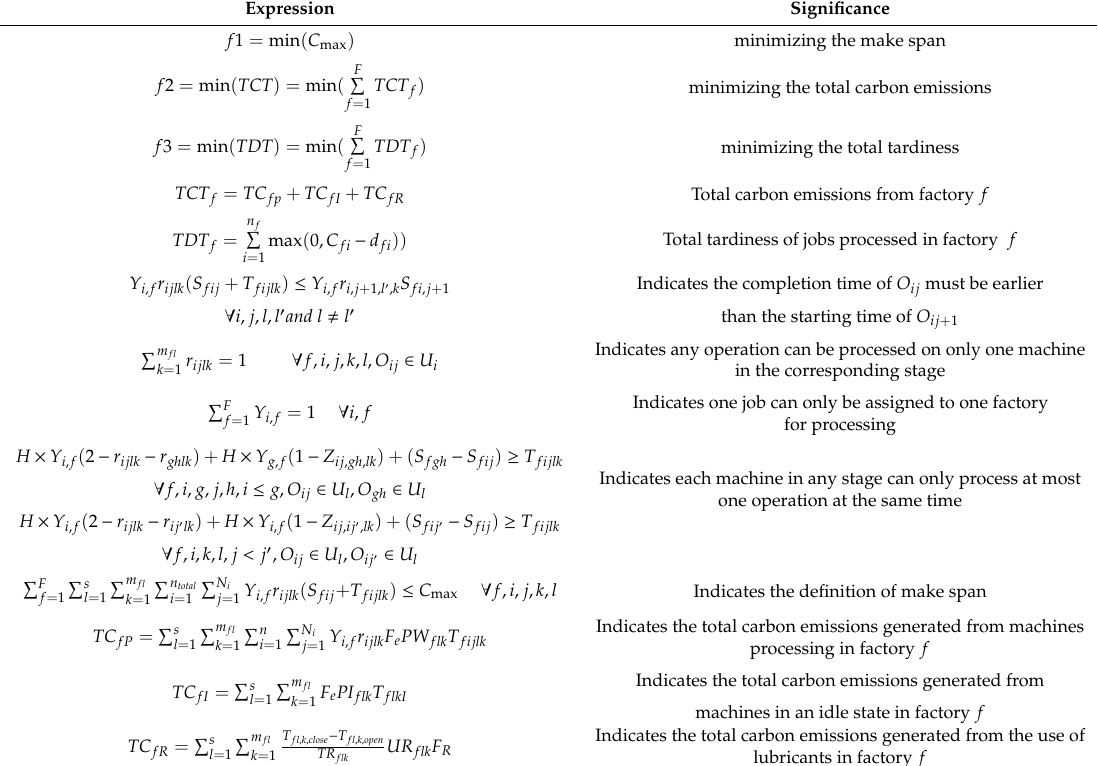
Table 2. Objective functions and